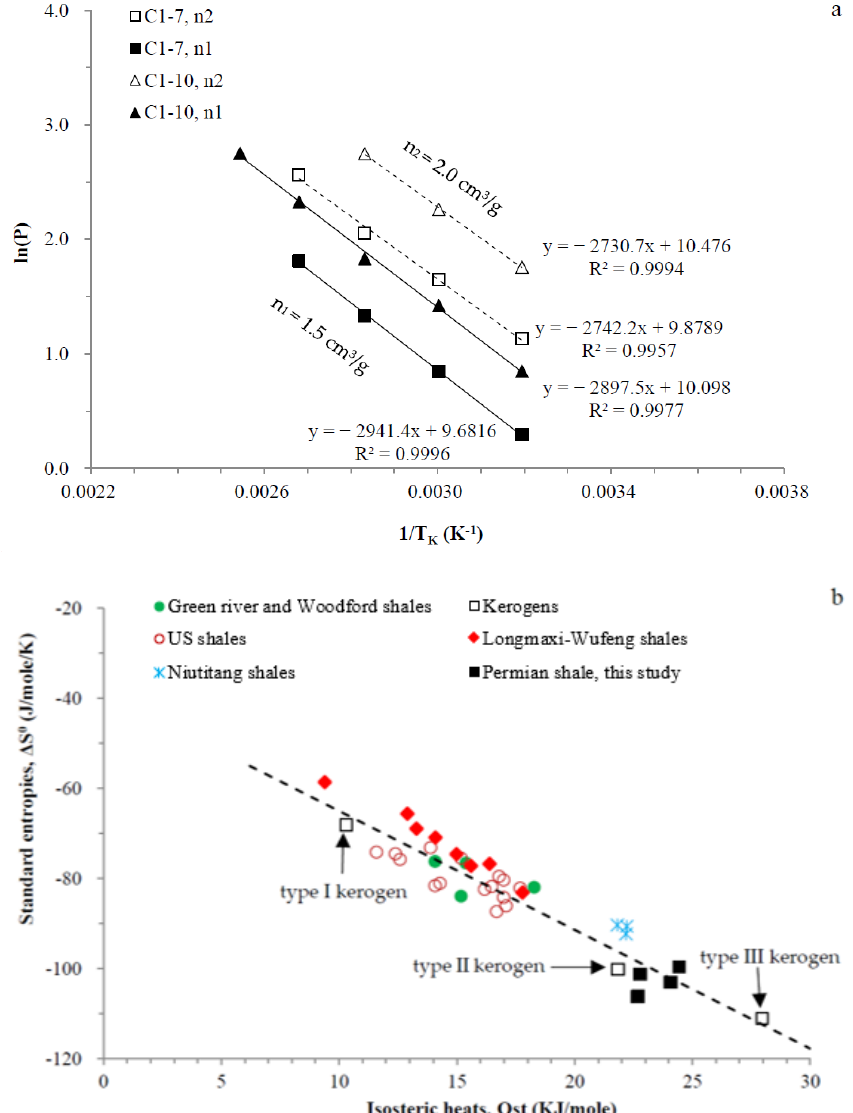
Figure 11. ( a ) Plots of ln(P) versus the reciprocal of the Kelvin temperature of Sample C1-7 and C1-10; ( b ) The linear relationship between the isosteric heats and standard entropies for the Permian shale and other shales and kerogens [7,14,53,63].